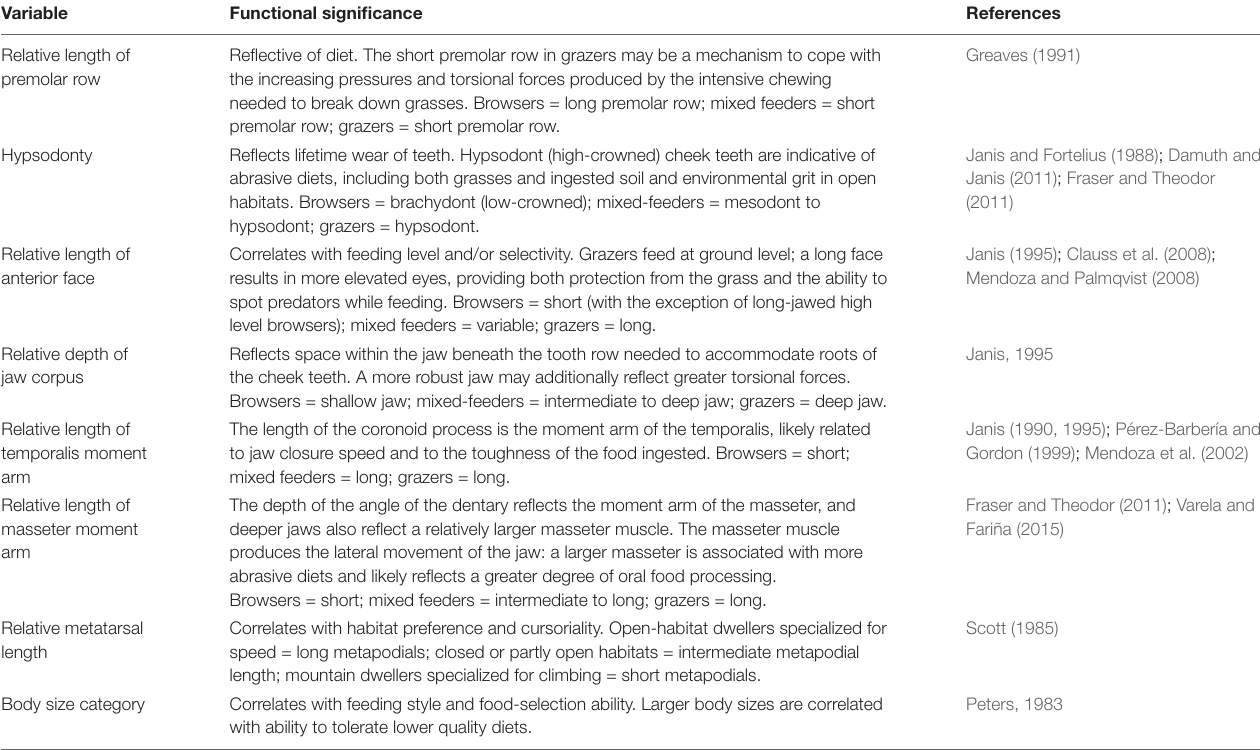
TABLE 1 | Categorical variables used in the correspondence analysis and their ecological significance. Variable Functional